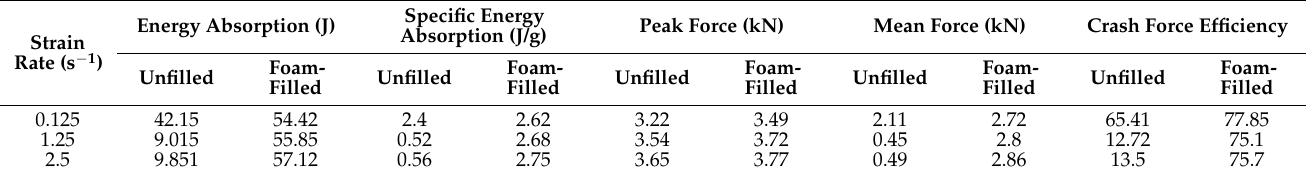
Table 3. Crash force analysis of unfilled and form-filled lattice